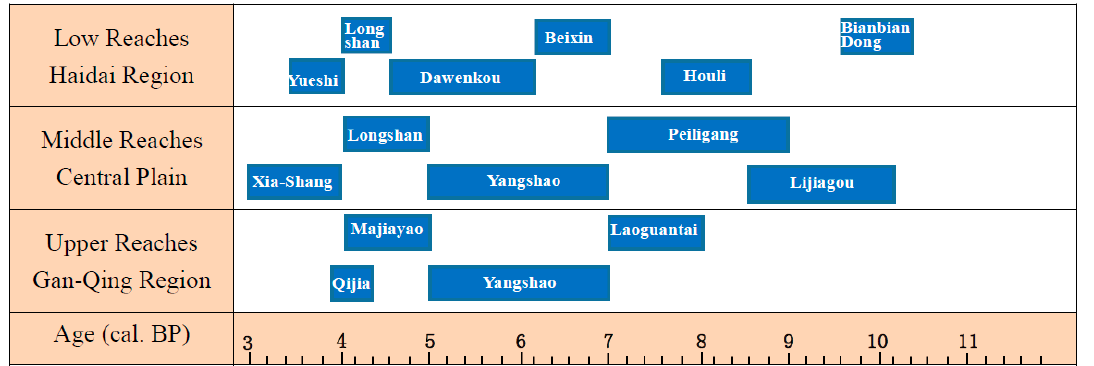
Figure 1. Archaeological cultural sequence and chronology during the Neolithic-Bronze Ages in the Yellow River Basin.